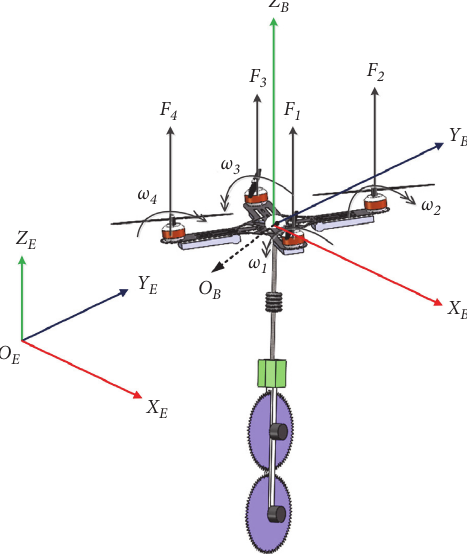
Figure 1: The inertial and body frames.